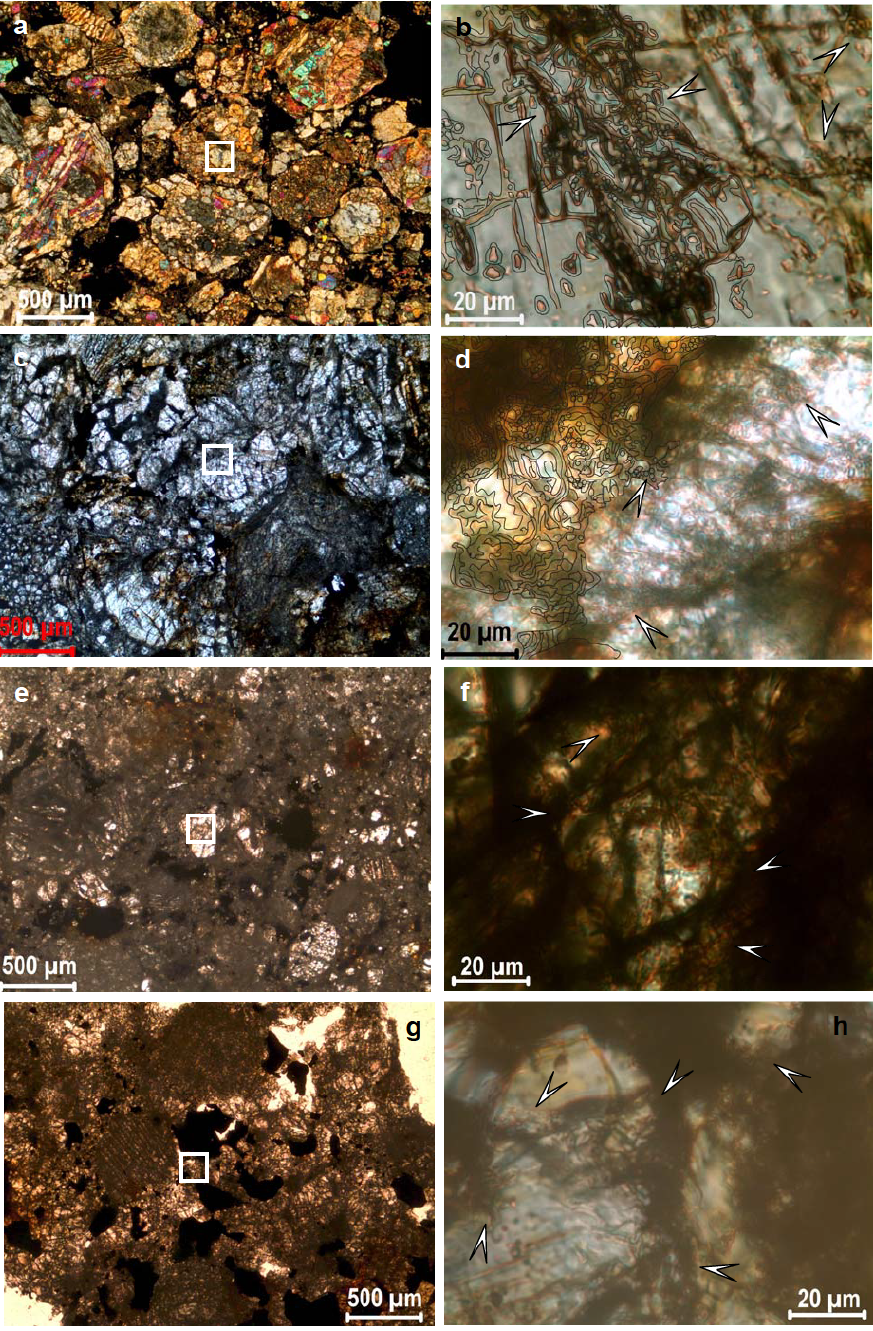
Figure 3. Microbial alteration sequence as alternative opportunity near thermal metamorphic sequence of the L-group chondrites (a-b)- Mező-Madaras L3.7, (c-d)-Knyahinya L/LL5, (e-f)-Nyírábrány LL5/L6, (g-h)-Mócs L6. We can observe how the sharp edges of chondrules gradually become fuzzy via homogenization caused by more and more intense clay formation from L3 to L6 (a, c, e, g), which process is called as Oswald-maturing in solid state physics for thermal metamorphism. (b, d, f, h) show filamentous microbial morphology with pearl necklace-like inner texture of colonies embedded in all chondrites of the marked areas (arrows). Optical rock microscopy, transmitted light 1N, except (a) which is crossed N. Some features in photos (b, d) were graphically enhanced for better recognition of MMPT due to low contrast of the